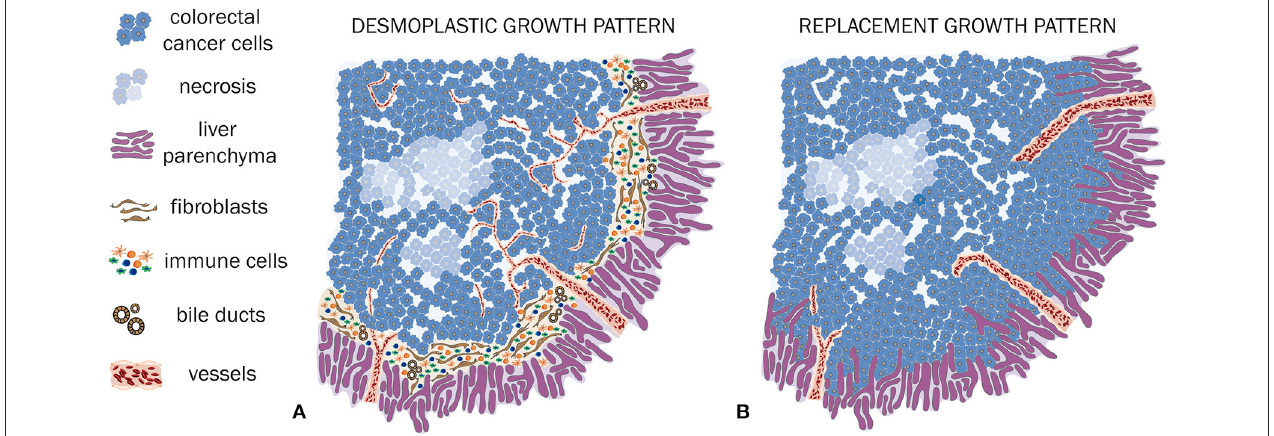
FIGURE 2 | HGP of CRCLM (A,B) . (A) Schematic illustration of a desmoplastic CRCLM. Hereby, the defining desmoplastic rim between tumor and liver tissue is clearly visible. A dense immune cell infiltration is surrounding and also invading the metastasis. Within the desmoplastic rim, the ductular reaction is illustrated. The ingrowing vessels demonstrate sprouting angiogenesis, which is characteristic for desmoplastic CRCLM. (B) Schematic illustration of replacement CRCLM. This type of metastases is characterized by tumor cells, mimicking the liver architecture, co-option of mature pre-existing vessels, and absence of an inflammatory and fibroblastic rim.